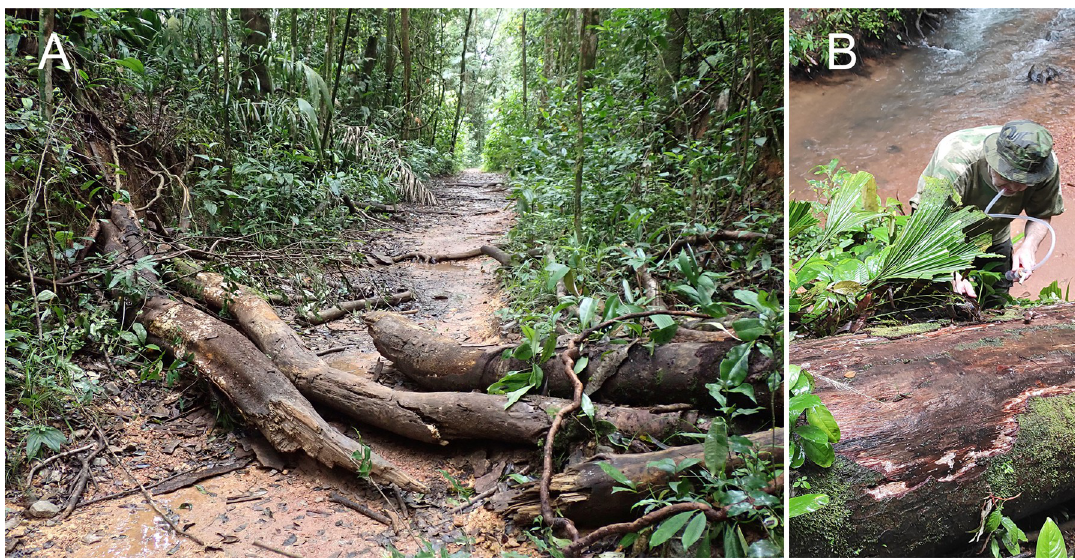
Fig 4. Habitat of Latinozoros cacaoensis sp. nov. A: Rotting logs on Sentier du Bagne des Annamites track (French Guiana: Montsine´ry env.) where paratypes were collected. Photo: P. Ko č a´rek; B: collecting of L . cacaoensis sp. nov. by the author (PK) at the type locality on Moloko ï track (French Guiana: Cacao env.). Photo: I.H. Tuf. Gimmel DR04 // under bark of wet, rotten Pinus occidentalis ’ (NMPC); paratypes with same data as for holotype: 2 females (NMPC); additional material examined: ’Trinidad: Northern range, Las lapas W. of summit of Blanchisseuse Road, 1800 ft, 18. February 1964, J. G. Rozen & P. Wygodzinsky’, 1 female (AMNH: IZC00321203). Diagnosis Latinozoros gimmeli sp. nov. (Figs 6 and 7) is morphologically similar to both L . barberi (Gur- ney, 1938) [30] and L . cacaoensis sp. nov., and can be distinguished by the specific shape of its male genitals. The anterior process of the basal plate of the male genital is about 1.5 times lon- ger than the ventral sclerites in L . gimmeli sp. nov., and the distal processes of the ventral scler- ites are long and narrowed (Fig 7B and 7C). In L . barberi , the anterior process of the basal plate is long, at least 3 times longer than the ventral sclerites, and the distal processes of the ventral sclerite are very broad and rounded; in L . cacaoensis sp. nov. the anterior process of the basal plate is short, as long as the ventral sclerite (sclerite III), the posterior processes of the ventral sclerites are 2 times longer than anterior processes, with broadly rounded apex. Differ- ence is also in the arrangement of the spurs on metafemur, whereas the ventral surface of metafemur bears 9 stout spurs in L . barberi and L . gimmeli sp. nov. (Fig 6E) but only 7–8 stout spurs in L . cacaoensis sp. nov. (Fig 1C). Females of L . cacaoensis sp. nov. and L . gimmeli sp. nov. differ also in the shape of the eight sternite (S8). Middle part of the distal end of S8 extends to triangular projection in L . gimmeli sp. nov. (Fig 6H), but the distal end of S8 is broadly rounded in L . cacaoensis sp. nov. (Fig 2D). Shape of S8 in female of L . barberi is unknown, because the female of this species is not described.